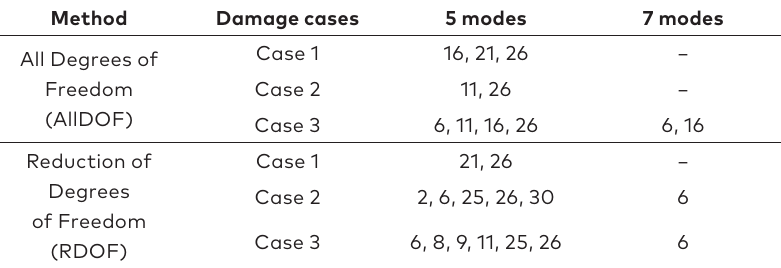
Table 7. False elements identified for the